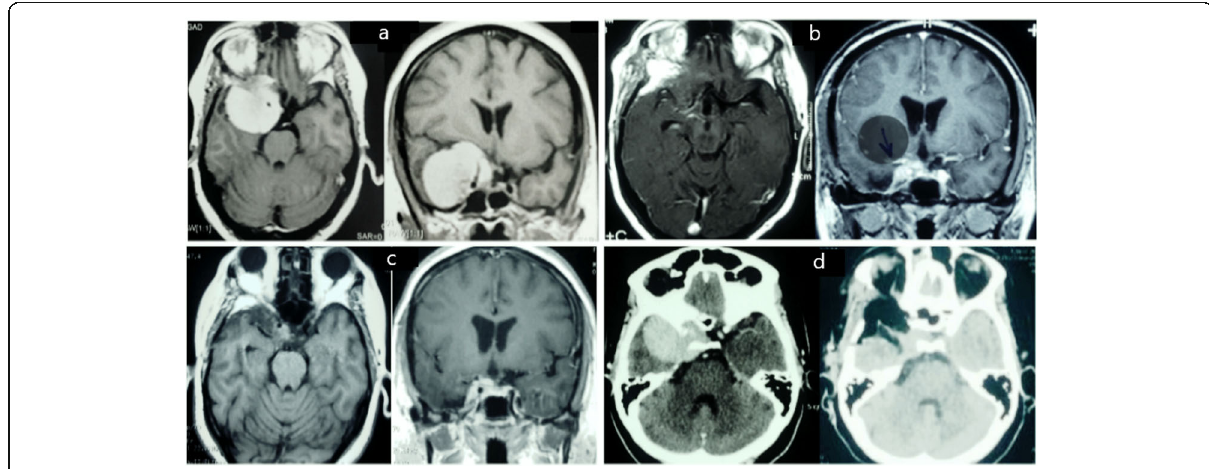
Fig. 3 a – d Preoperative and postoperative imaging of case 1 with right ACM (type I). a MRI brain with enhancement axial and coronal view showing right ICA encasement and CS invasion by the tumor. b Postoperative MRI with enhancement showed the extent of tumor resection. c Last follow-up MRI with enhancement after SRS-GK, tumor control with no regrowth was achieved. d Immediate postoperative CT scan showing the right anterior clinoid was